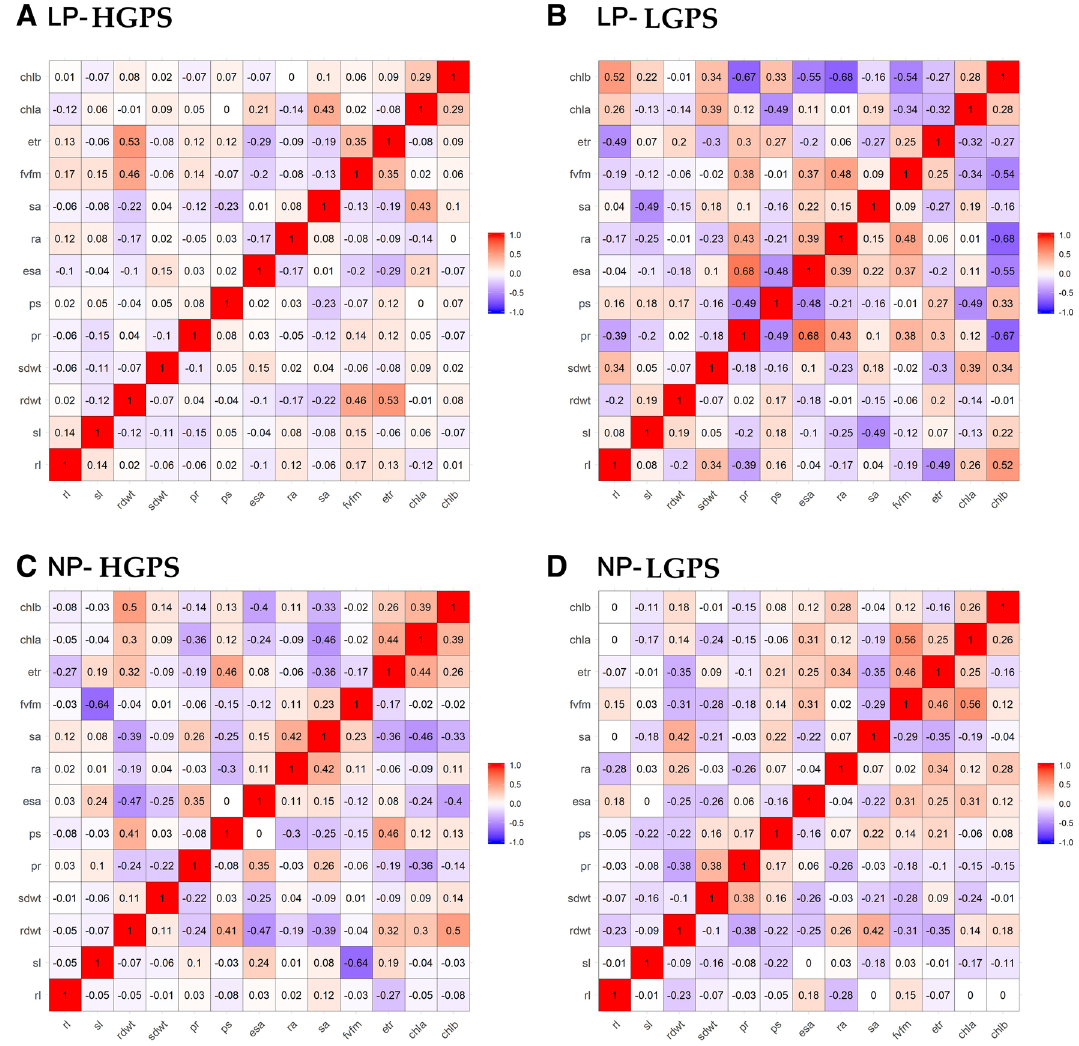
Figure 17. Correlogram of traits under LP and NP conditions in HGPS and LGPS at 24 days. The scale represents Pearson correlation values. Blue and red colours represent negative and positive correlation, respectively. root length (rl), shoot length (sl), root dry weight (rdwt), shoot dry weight (sdwt), P content in root (pr), P content in shoot (ps), P content in grain (pg), externally secreted acid phosphatase (esa), root acid phosphatase (ra), shoot acid phosphatase (sa), grain length (gl), grain width (gw), grain area (ga), (fvfm) electron transport rate (etr), chlorophyll A content (chla), chlorophyll B content